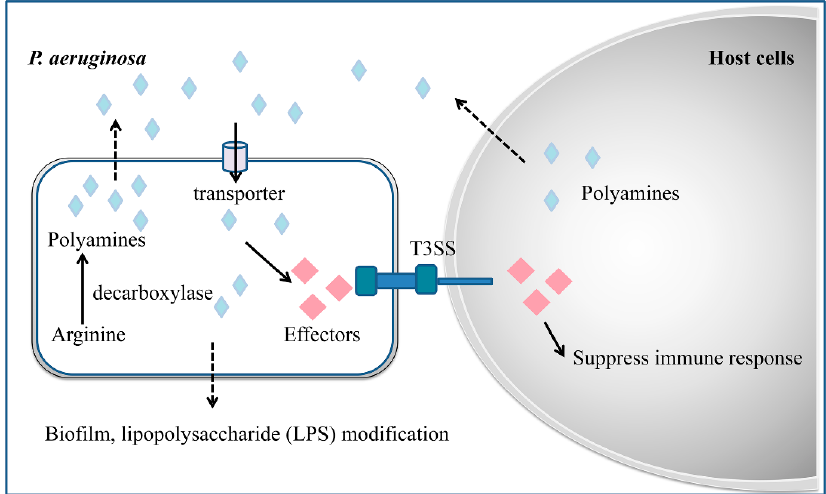
Figure 2. The role of the polyamine chemical communication system in modulation of virulence and antibiotic resistance in P. aeruginosa . Microorganisms synthesize polyamines by themselves using arginine as the substrate or can uptake polyamines from host cells or the surrounding environment throughspecifictransporters, whichinduceexpressionofthegenesencodingvirulencefactorproduction, biofilm formation, and coordinate responses to oxidative